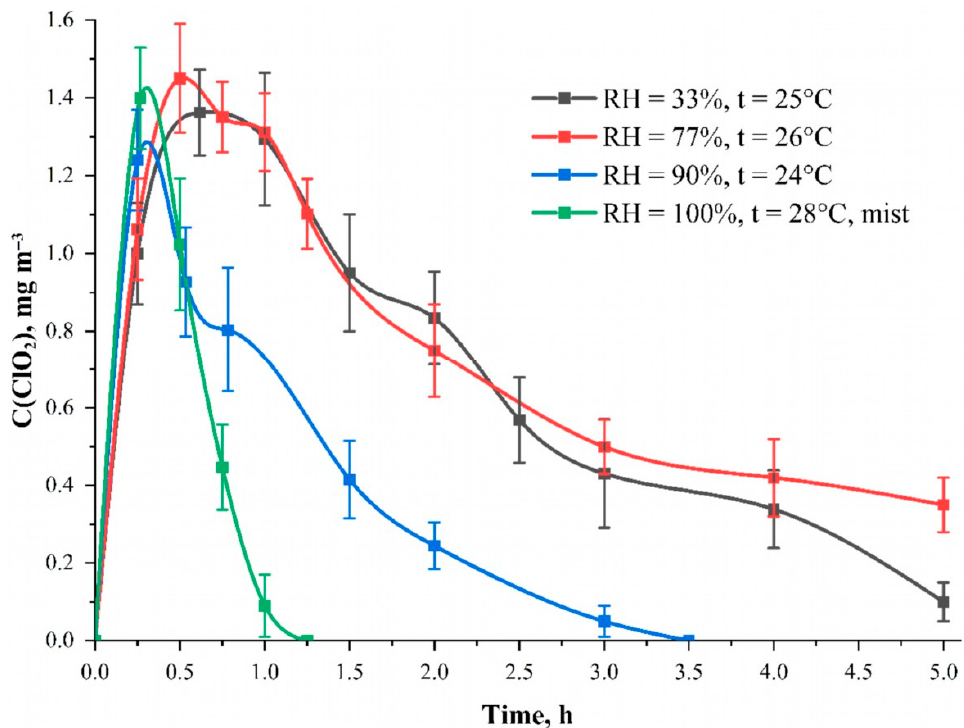
Figure 6. The dependence of the generated ClO 2 concentration inside the aspiration camera on time at different air humidity. The curve “RH = 100%, t = 26 °C mist” corresponds to the humidity value of 100% checked by a hygrotermometer with visual observation of fog. Solution—C(NaClO 2 ) = 25.0 mmol L –1 ; solvent—95 wt. % aqueous ethanol solution; carrier—cotton cellulose fabric with the content of phosphorus-containing groups equal to 0.802 ± 0.082 mmol g –1 .